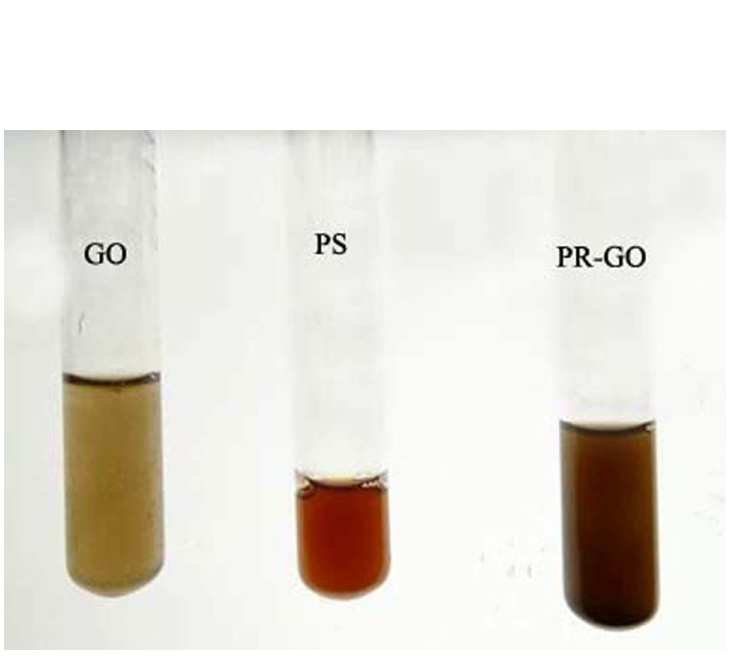
Fig 2. From left, dispersed and exfoliated graphene oxide, aqueous solution of the polysaccharide, polysaccharide-reduced graphene oxide.